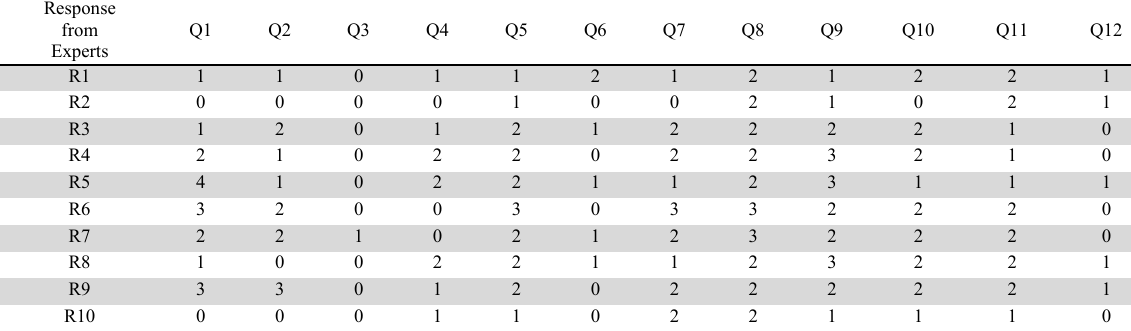
Difference with reference sequence values